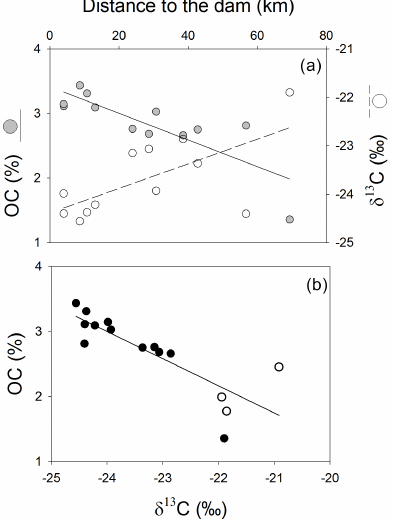
Figure 4. (a) Variation in OC content (%) and OC isotopic com- position ( δ 13 C, ‰) of top sediment of pelagic sites related to the distance to the dam. The lines represent the linear trend of variation for OC (solid line, gray circles) and for δ 13 C (hashed line, white circles). Spearman correlation coefficient for OC was r = 0 . 81 ( p< 0 . 001) and for δ 13 C was r = − 0 . 53 ( p = 0 . 07). (b) Relation- ship between OC content and OC isotopic composition ( δ 13 C) of top sediment in all sampling sites. Open circles correspond to sites by the margins and closed circles correspond to pelagic sites. The solid line represents the linear trend of variation for all sites. Corre- lation between these variables was strong ( r = − 0 . 90, p< 0 .